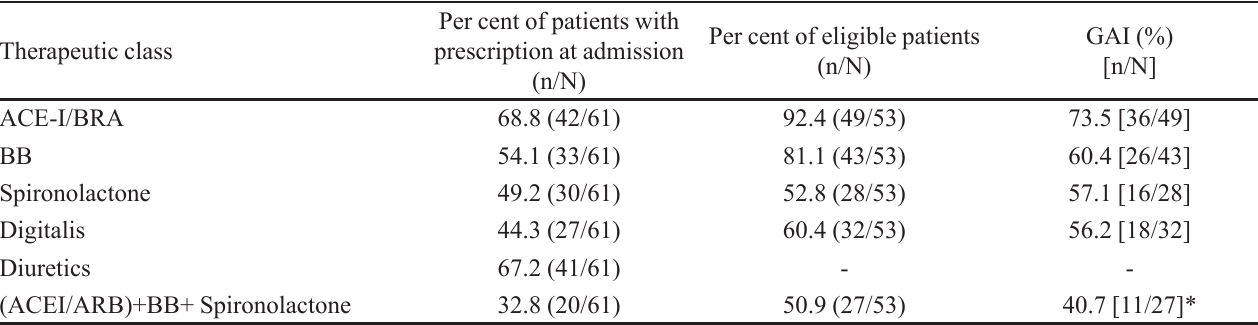
TABLE III - Proportion of patients with medications for HF at the time of admission, eligible patients and the GAI for each pharmacological